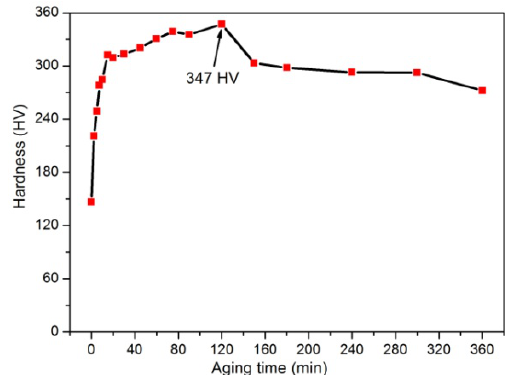
Fig. 6 Hardness variation versus aging time of Cu–15Ni–8Sn– 0.8Nb alloy.